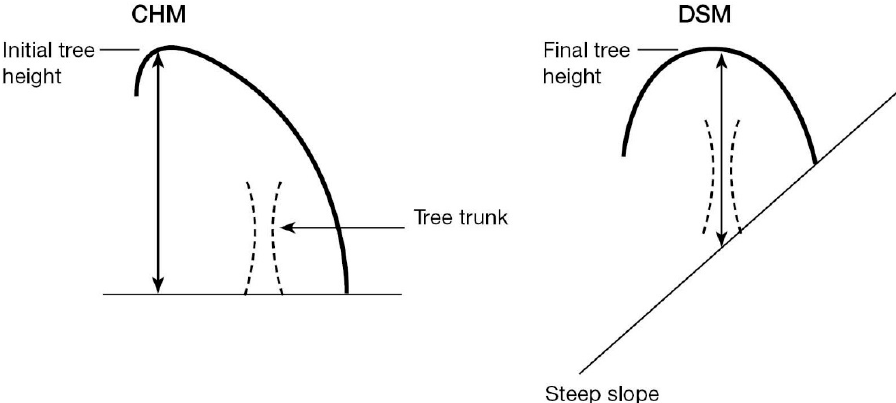
Figure 1. Sketch of initial tree top position as derived from the CHM (canopy height model) using local maxima filtering ( left panel ) and new tree top position ( right panel ) defined as the highest point in the DSM (digital surface model) within the tree crown boundary minus the DTM (digital terrain model).